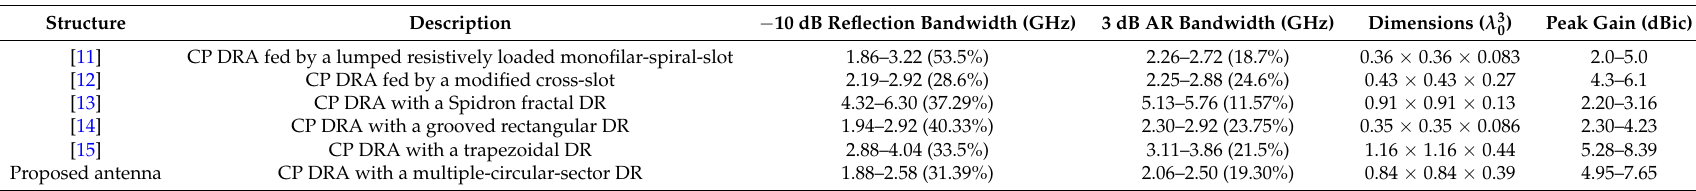
Table 2. Comparison of the proposed antenna with antennas in previous studies. Note that λ 0 is the wavelength corresponding to the center frequency of the AR band. CP: circularly polarized; DRA: Dielectric resonator